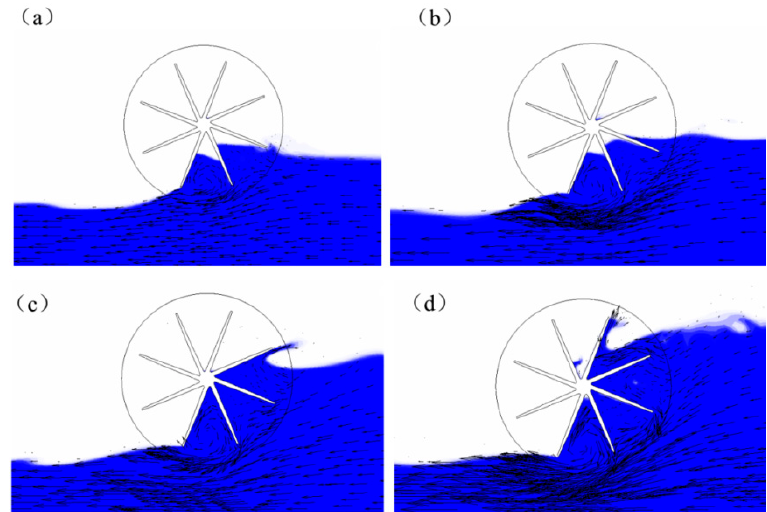
Figure 13. Velocity vectors at circumferential angle ϕ = 201 ◦ . ( a ) The immersed depth of 0.6 m; ( b ) the immersed depth of 0.8 m; ( c ) the immersed depth of 1.0 m; ( d ) the immersed depth of 1.2 m.